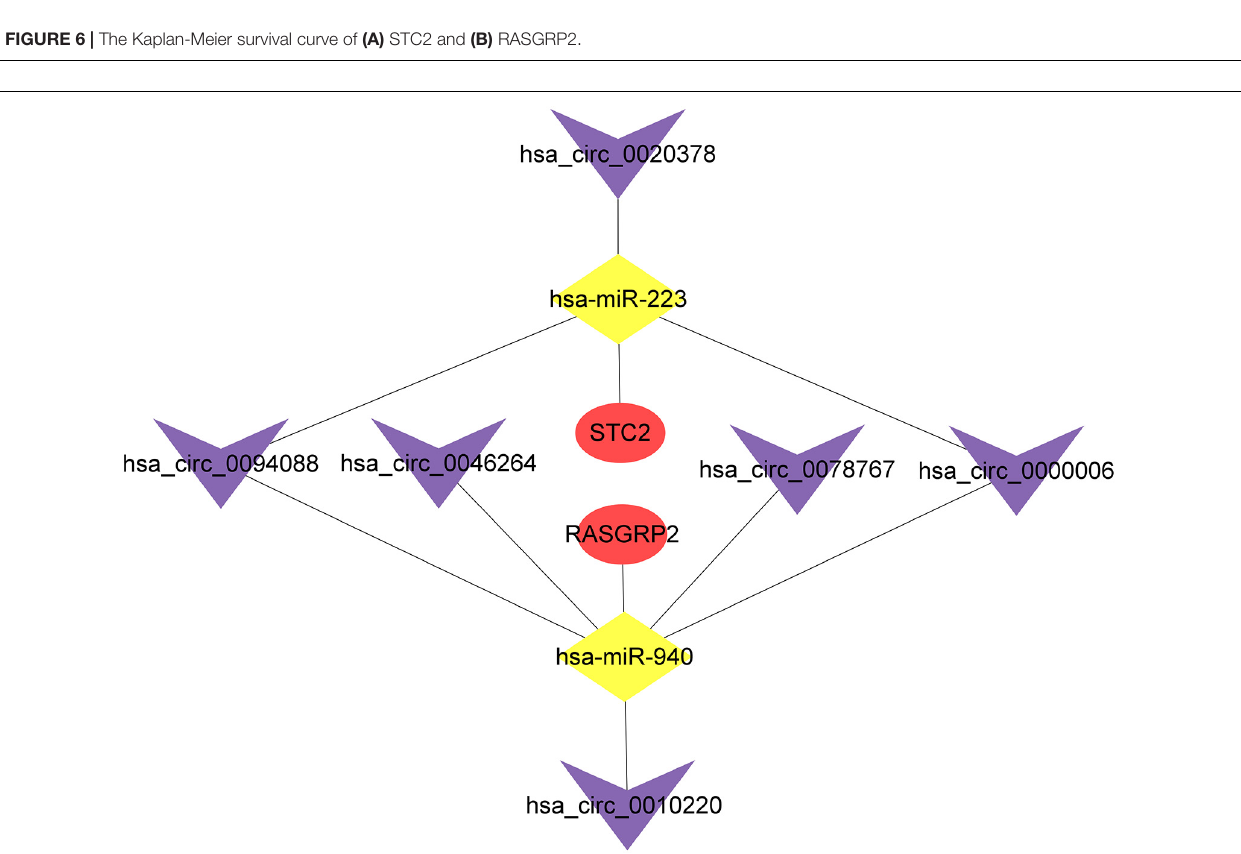
FIGURE 7 | The circRNA-miRNA-mRNA subnetwork based on mRNAs screened out with prognostic value. The purple V represents circRNAs, the yellow diamond represents miRNAs and the red oval represents